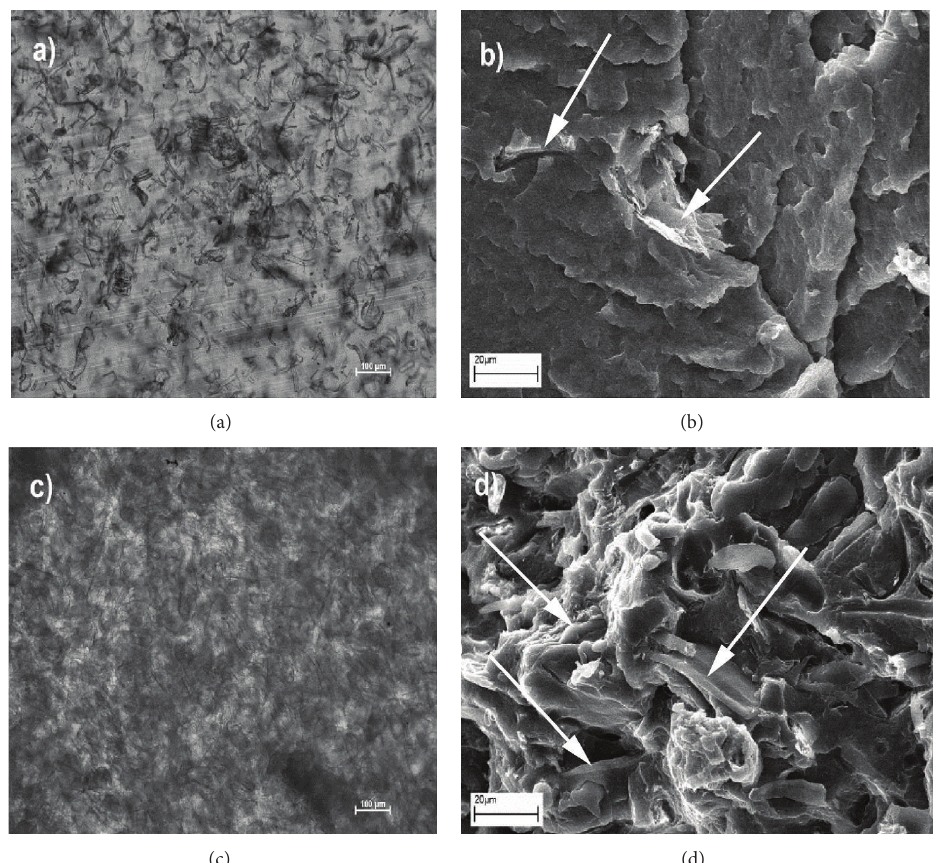
Figure 19: Optical and SEM macrographs of PLA filled with 5 wt% cellulose (a and b) and PLA filled with 30 wt% cellulose (c and d), respectively